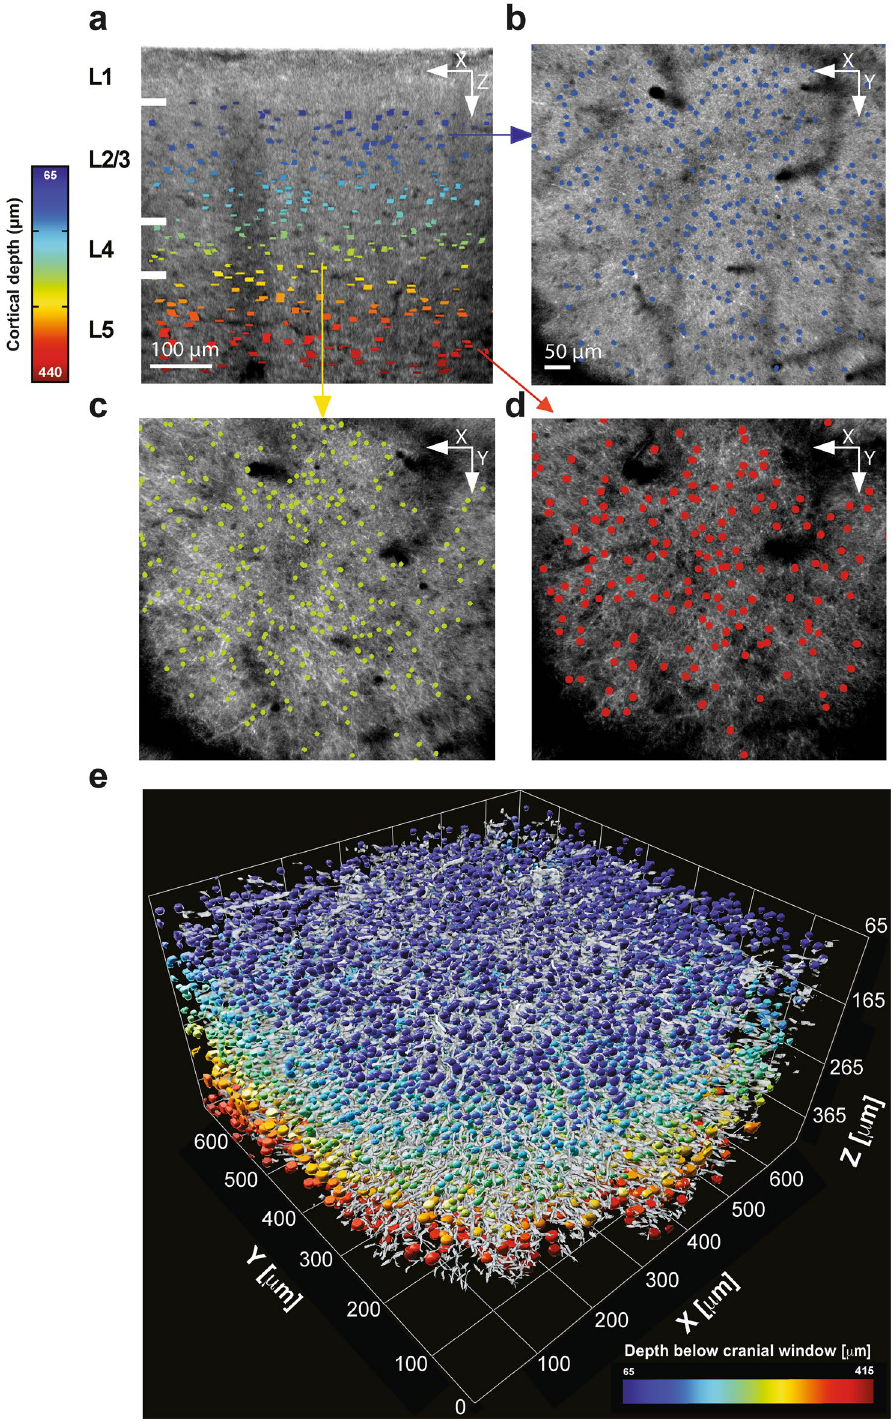
Figure 2. Feature segmentation method allows for micron-scale 3D visualization of the cortex. ( a ) A sampled b-scan overlaid with the segmented CNS cell bodies; color encodes depth below the cranial window ( b–d ) Sampled en face images overlaid with the segmented CNS cell bodies at cortical depth ( b ) 132 µm, ( c ) 255 µm, and ( d ) 380 µm. ( e ) Visualization of a 3D CNS segmentation mask of brain neural networks in a living mouse at micron-level resolution, with a color-encoded depth of more than 10,000 CNS cell bodies, and their surrounding myelinated axons (grey); volume dimension is 0.7 X 0.7 X 0.4 mm